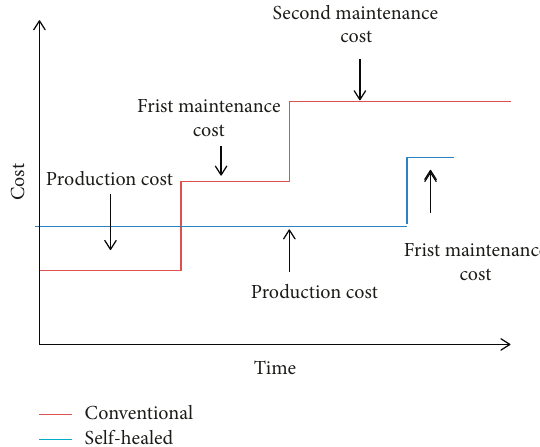
Figure 4: The cost analysis estimate of self-healed concrete (blue line) and conventional concrete (red line), adopted from